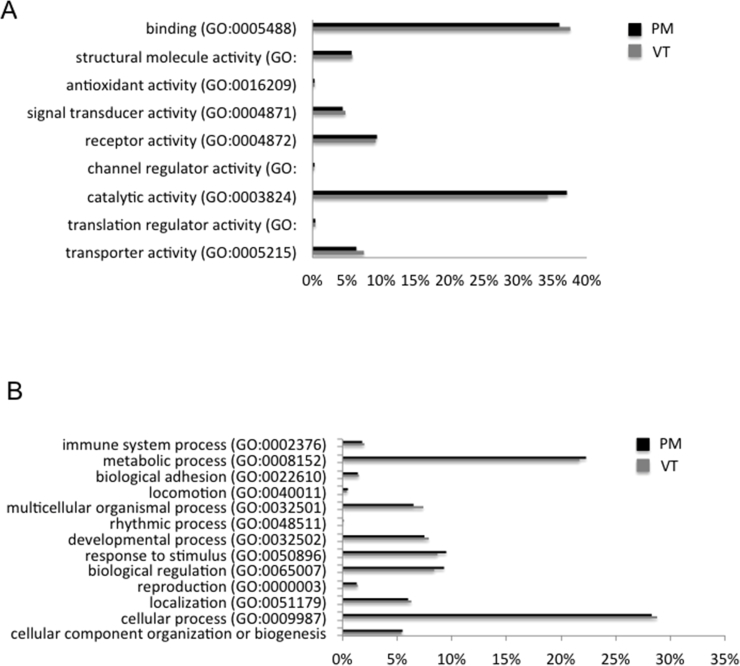
Functional classification of DE genes in monocytes exposed to VT-/PM+ and VT+/PM- IgG using Panther-GO (http://www.pantherdb.org/) analysis tool. Gene ontologies (GO) for Molecular function (A) and biological process (B) are shown.